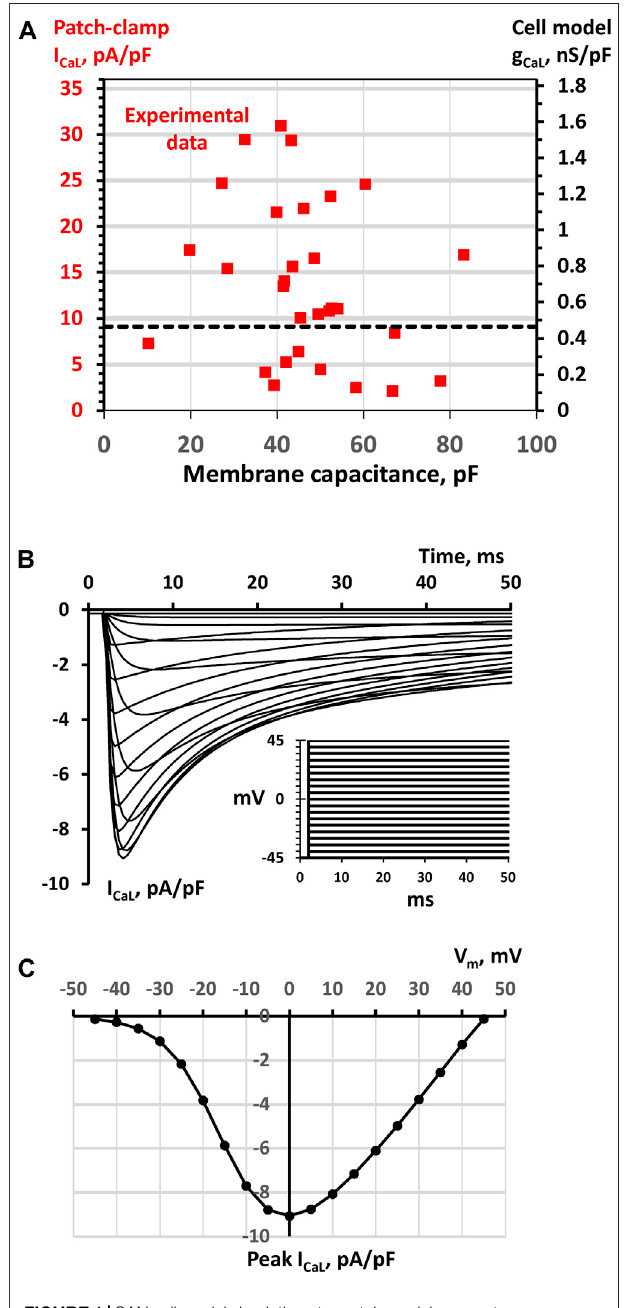
FIGURE 1 | SAN cell model simulations to match model parameter g CaL to I CaL density measured experimentally (A) A double Y scale plot of experimentaldatapointsof I CaL densitiesmeasuredbywhole-cellpatchclamp in a large population of SAN cells (red squares, left Y axis, replotted from (Monfredi et al., 2018)) and respective model g CaL parameter values (right Y axis) (B) Traces of I CaL / V m relationship simulated in Maltsev-Lakatta single cell model with the basal state value of g CaL = 0.464 nS/pF using voltage clamp protocol (inset) and conditions similar to those in experimental study of (Monfredi et al., 2018). The family of I CaL traces was simulated by applying a series of square voltage pulses from a holding potential of -45 mV with a step of 5 mV up to 45 mV (inset). Before each stimulation, I CaL activation and inactivation gating variables f L and d L were set to their steady-state values.